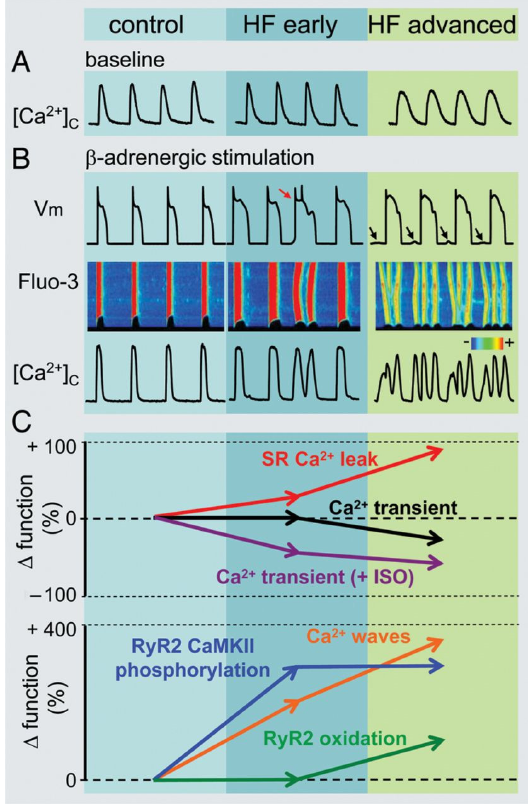
Figure 8. Heart failure progression and remodeling of calcium handling. ( A ) Representative Ca 2+ transients recorded from dog isolated myocytes from controls, from early and advanced stages of heart failure. ( B ) Representative action potentials (Vm), along with line scan Fluo-3 fluorescence images and Ca 2+ transients ([Ca 2+ ] c ) during β -adrenergic stimulation in control, early and advanced HF canine myocytes. The red arrow indicates an extrasystolic action potential. Delayed afterdepolarizations are indicated by arrows. ( C ) Summary graphs of altered Ca 2+ handling in HF. Progression of HF causes early and progressive increase in sarcoplasmic reticulum Ca 2+ leak (upper graph, red line). The amplitude of the baseline Ca 2+ transient (upper graph, black line) decreases with significant time-delay compared to elevation of Ca 2+ leak during the progression of HF. This is attributable to the capacity of myocyte Ca 2+ handling for autoregulation. In contrast, the frequency of diastolic Ca 2+ waves recorded following β -adrenergic stimulation by isoproterenol (ISO) (lower graph, orange line) parallels increases in the SR Ca 2+ leak. Ca 2+ waves facilitate diastolic SR Ca 2+ loss leading to decreased in Ca 2+ transient amplitude (+ISO; upper graph, purple line). Importantly, in advanced stages of HF, persistent cytosolic Ca 2+ oscillations uncouple electrical excitation from mechanical response. Progressive alterations in Ca 2+ handling in HF are coupled to sequential modification of RyR2 by CaMKII-dependent phosphorylation (lower graph, blue line) and oxidation (lower graph, green line) [161] .